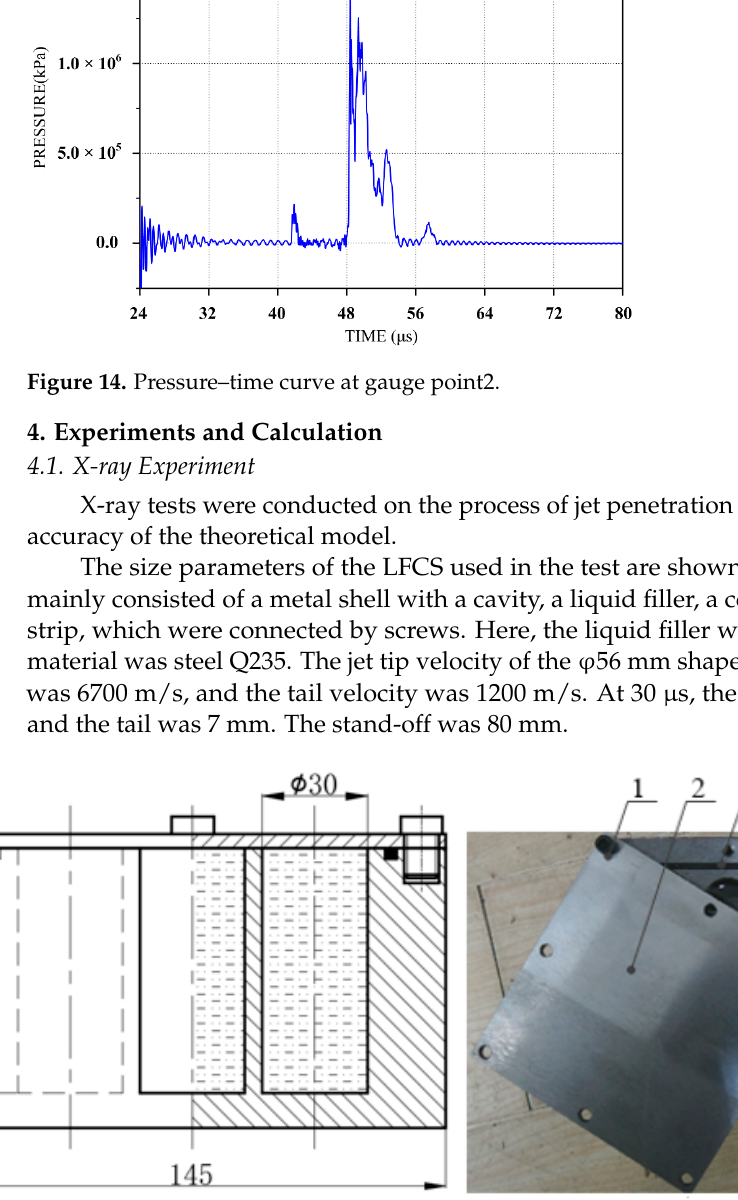
Figure 13. Y-velocity–time curve at gauge point 12.